Question: Compose a caption that would accompany this figure in a paper.
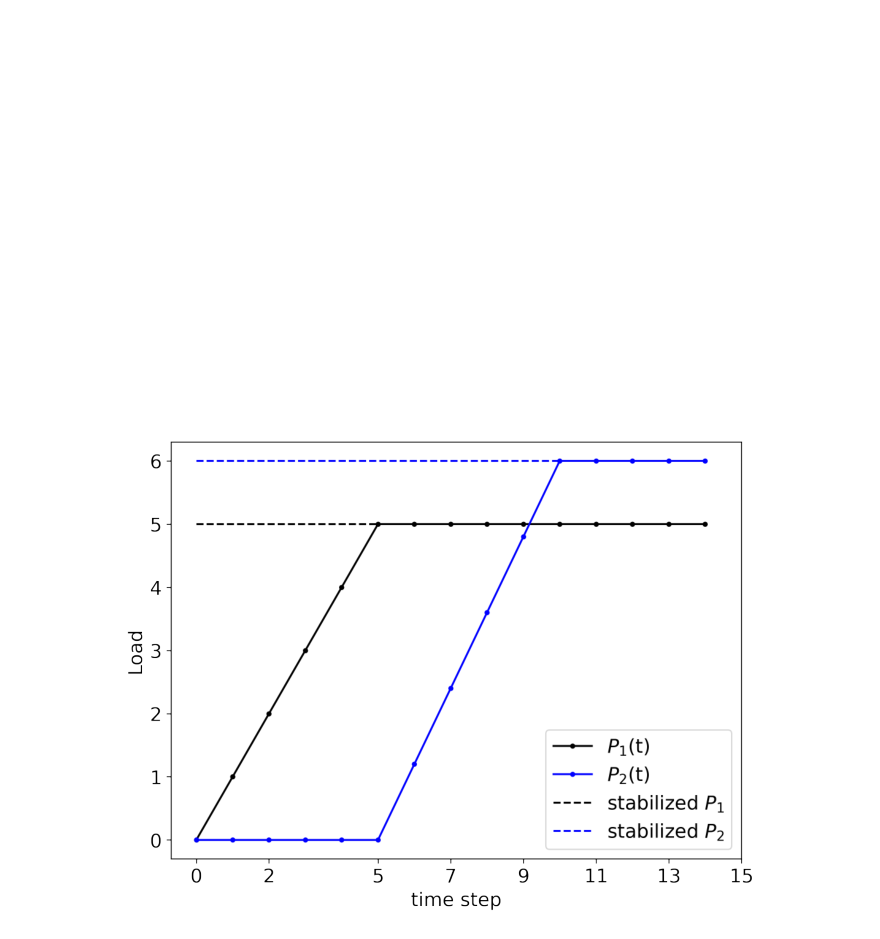
Answer: The pressure loads P1(t) and P2(t) as they change over time. The scalars P1 and P2 are the stabilized values of the loads.